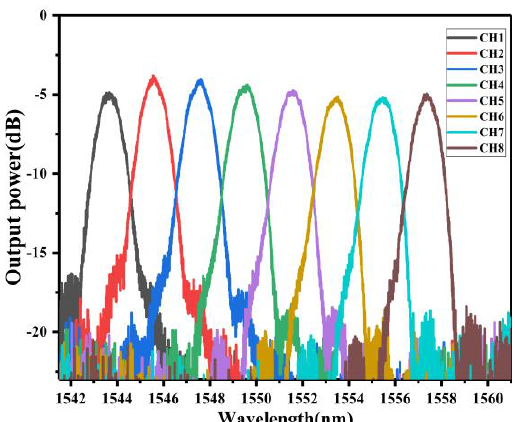
Figure 10. Experiment results of saddle-shaped 8 × 8 AWG.